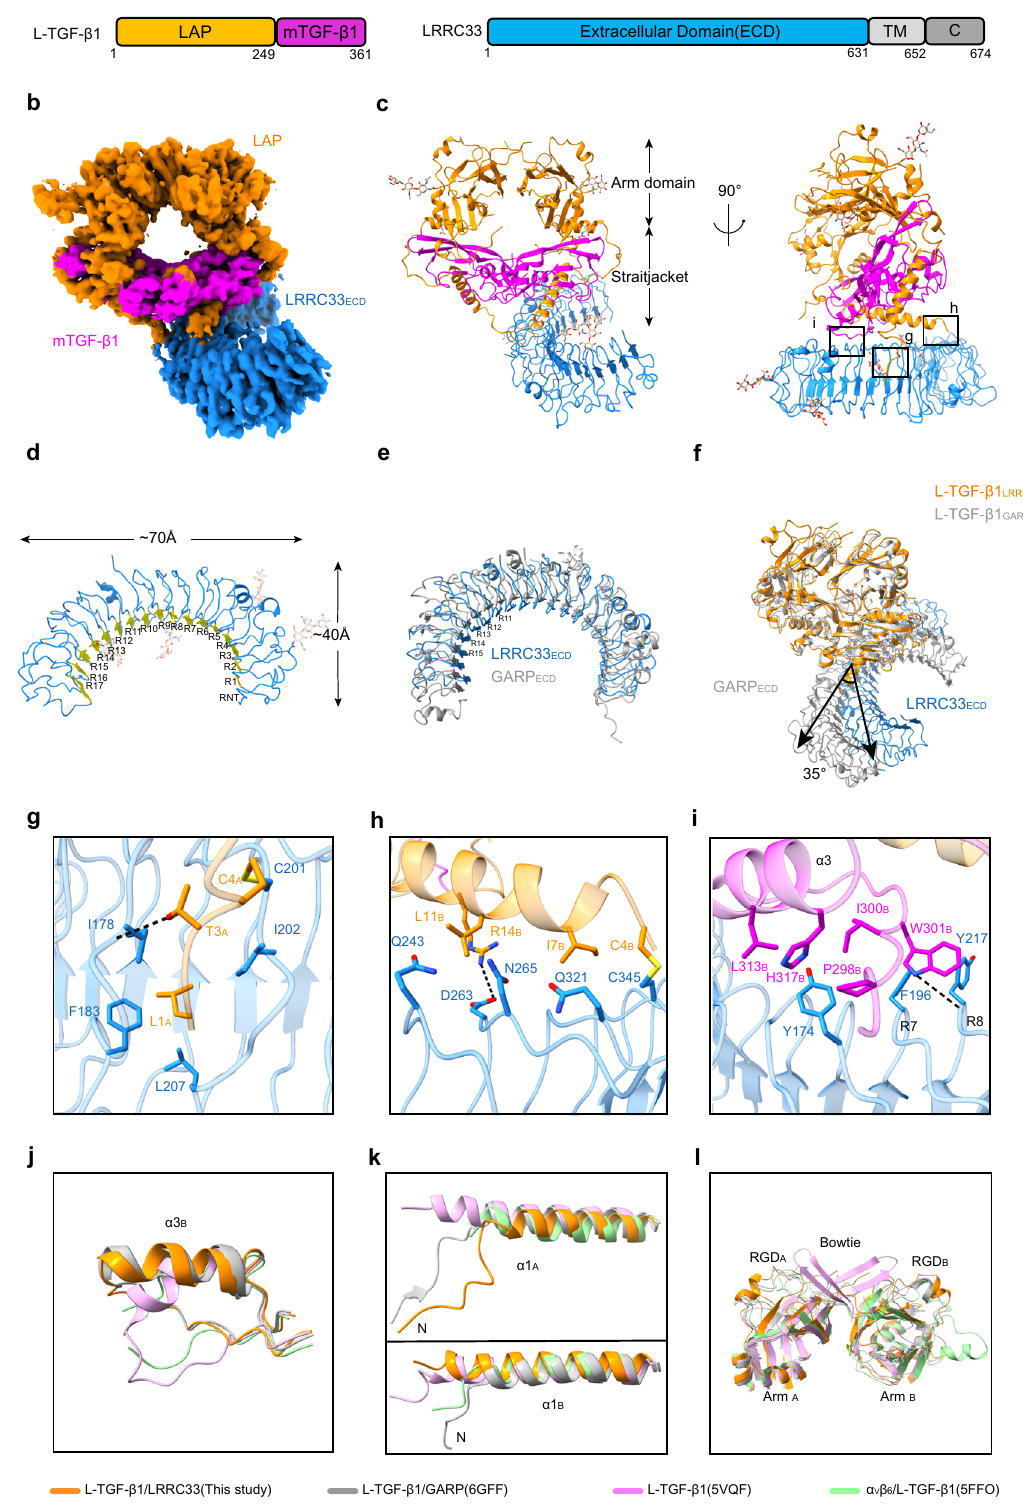
cognate residue of β 3 (i.e., K309T) but not β 2 (i.e., K309R) inhibited cell-surface presentation of L-TGF- β 1 by LRRC33 (Fig. 2g and Supple- mentary Fig. 5a). Although the side-chain density of Lys309 in mTGF- β 1/LRRC33 EM map, this residue β 1 B is not directly visible in the L-TGF- likely participates in van der Waals interactions with Cys98 and Ser100 of LRRC33 based on the structural model (Supplementary Fig.